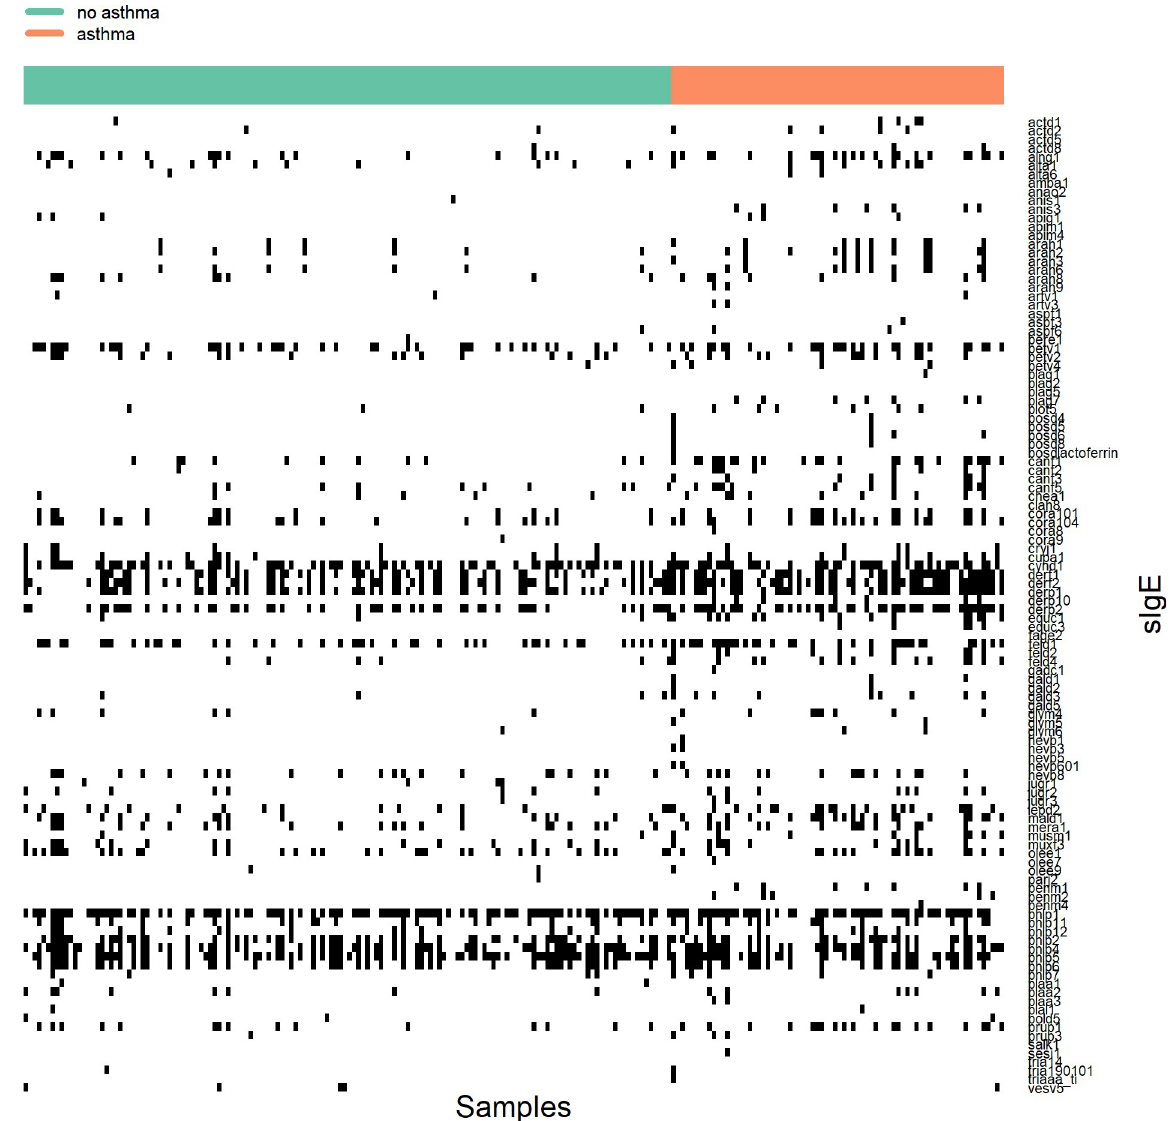
Fig 1. Patterns of sensitisations stratified by asthma status. Participants are represented in columns and sIgE components in rows. A black square indicates that a participant has a sIgE > 0.30 to a particular allergen component. sIgE, specific immunoglobulin E.